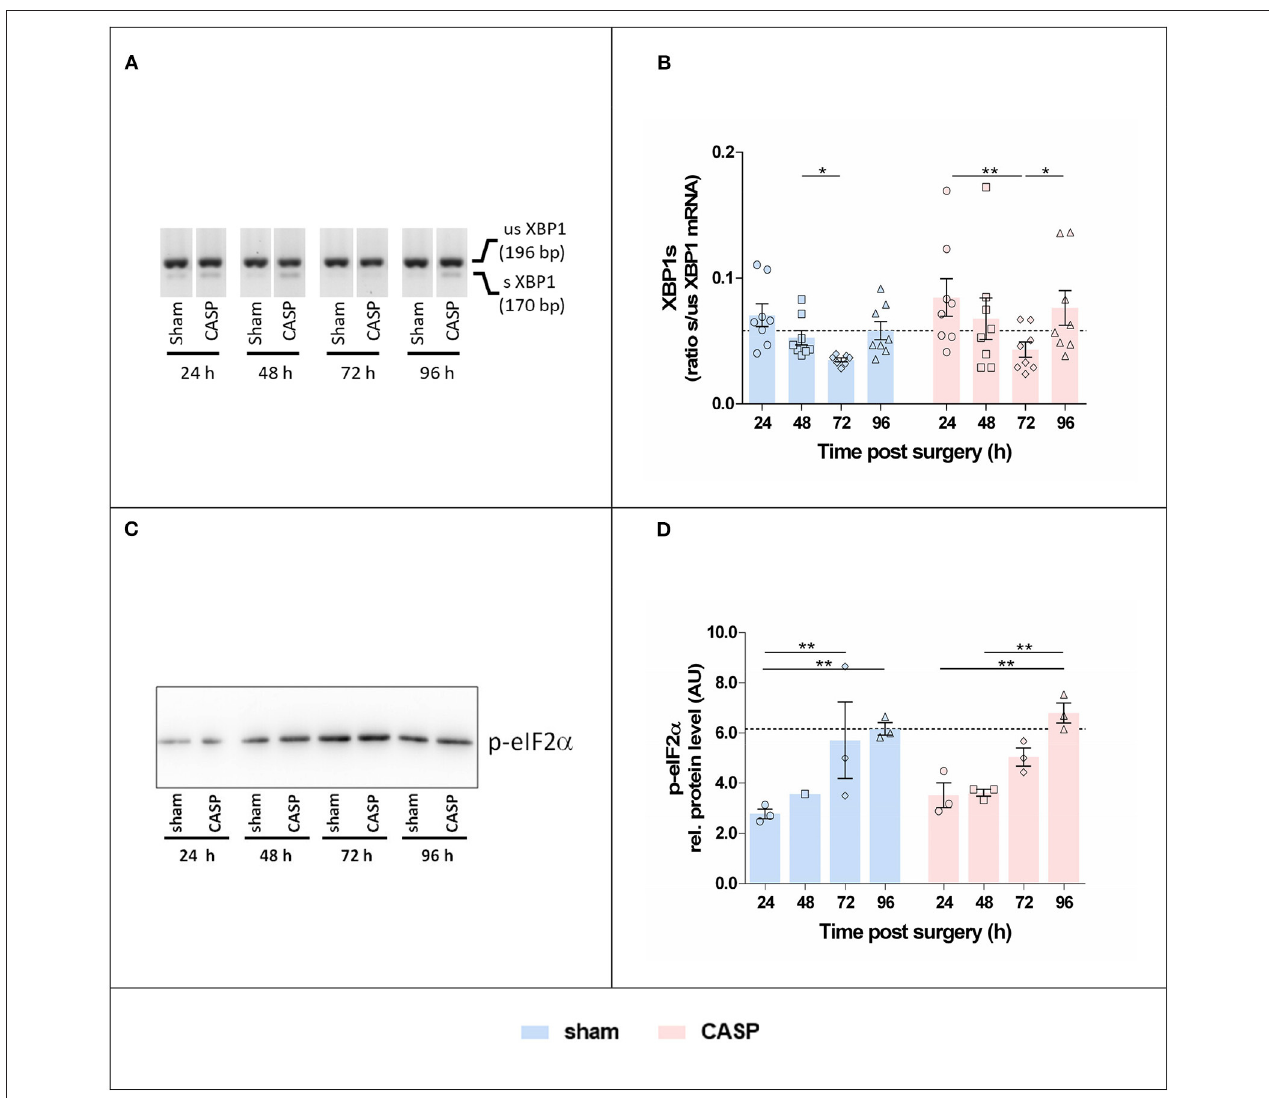
FIGURE 3 | Surgery induces hepatic XBP1 splicing and eIF2 α phosphorylation. (A) Representative agarose gel electrophoresis of XBP1 PCR products showing the occurrence of the splice variant in the liver. (B) XBP1s indicated as the ratio of spliced (s) to unspliced (us) XBP1 mRNA determined by densitometric analyses. Data are given as mean ± SEM ( n = 8 per group). (C) Liver homogenates were analyzed by SDS-PAGE and immunostaining for p-eIF2 α . An exemplary blot is shown (the entire blot is shown in Supplementary Figure S1A ). (D) Band intensities were normalized to the total protein of the respective gel lanes. Values are given as mean AU (arbitrary units) ± SEM ( n = 3 per group, except for sham 48h n = 1). The dashed line indicates the mean value of the sham group at 96h. Statistical differences were calculated using two-way ANOVA followed by uncorrected Fisher’s LSD test and are indicated by * p < 0.05, ** p < 0.01.